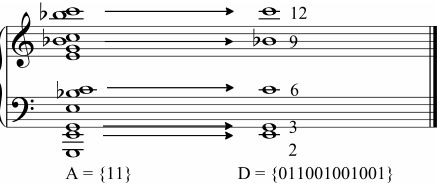
Figure 21. An example of a cluster generated with A = { 11 } and D = { 011001001001 } .